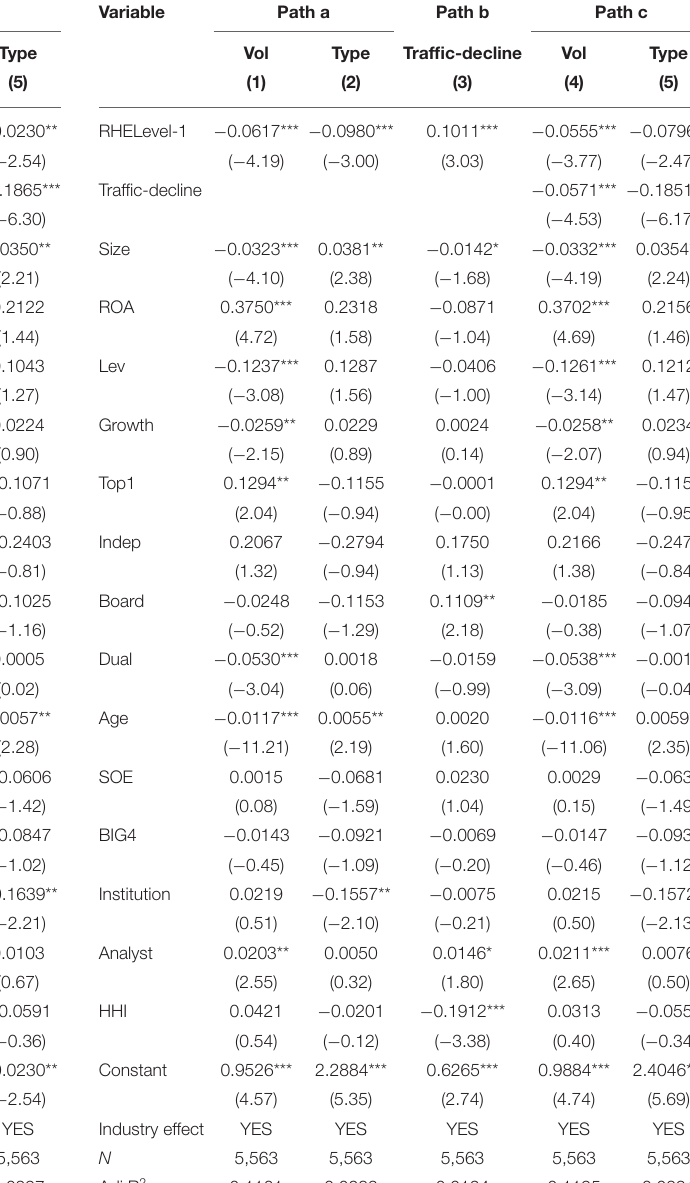
TABLE 10 | Evidence of the impact of traffic decline (X = Num). TABLE 11 | Evidence of the impact of traffic decline (X =